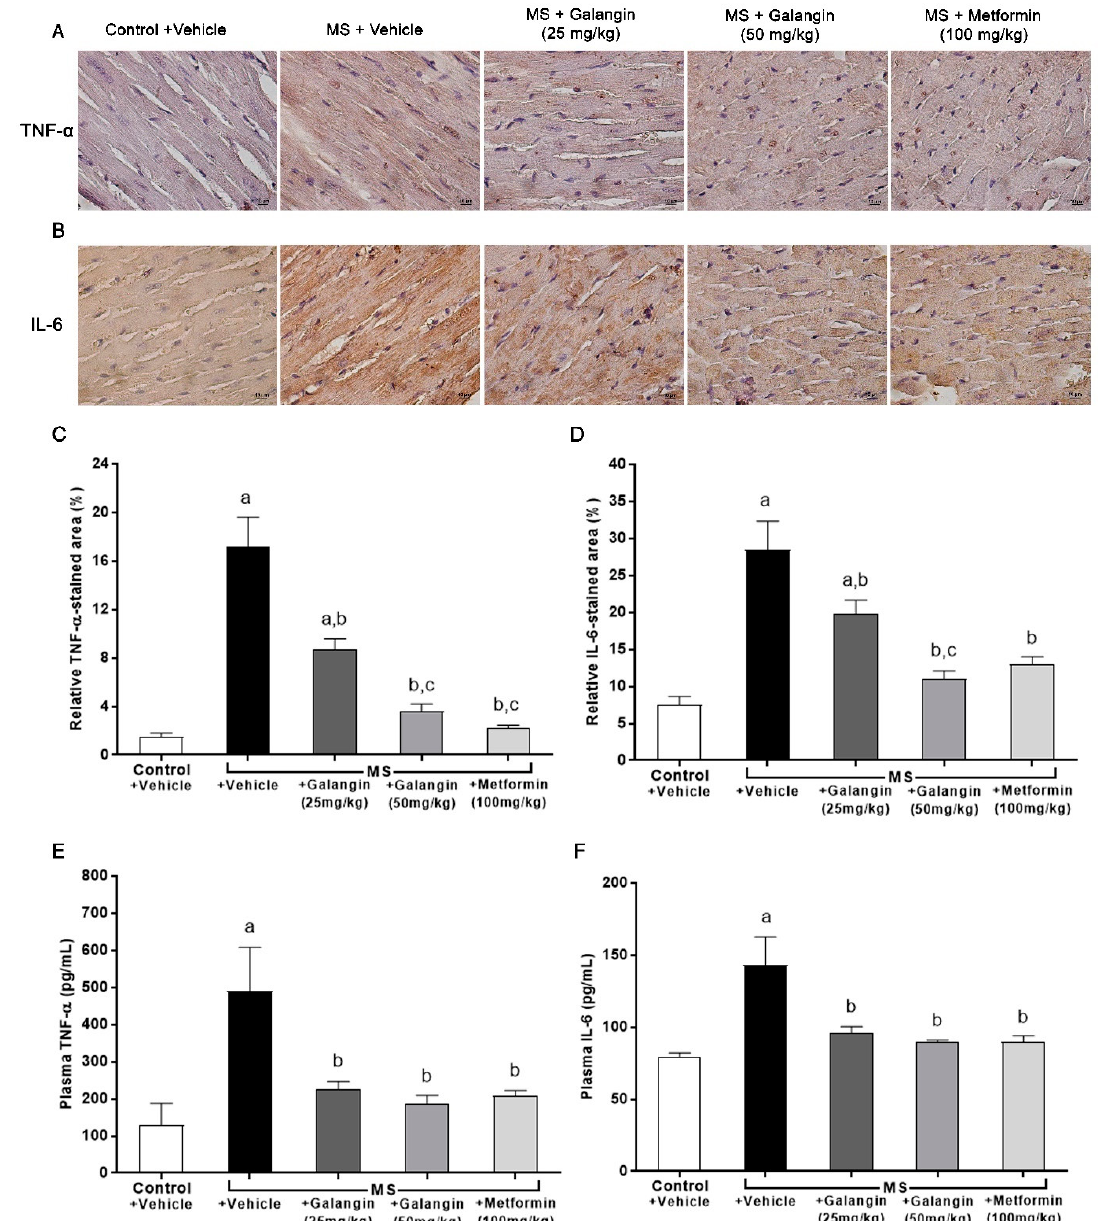
Figure 5. Effects of galangin and metformin treatments on tumor necrosis factor- α (TNF- α ) and interleukin-6 (IL-6) immunohistochemical staining for myocardial and TNF- α and IL-6 levels. ( A ) TNF- α , ( B ) IL-6 (Brown Chromogen) immunohistochemical staining in myocardia (magnification × 400) (scale bar = 10 µ m), ( C ) relative TNF- α -stained area (%), ( D ) relative IL-6-stained area (%), ( E ) plasma TNF- α , and ( F ) plasma IL-6. Results are shown as the mean ± S.E.M. ( n = 8). a p < 0.05 vs. the control group, b p < 0.05 vs. the MS group, and c p < 0.05 vs. the MS + galangin (25 mg/kg)